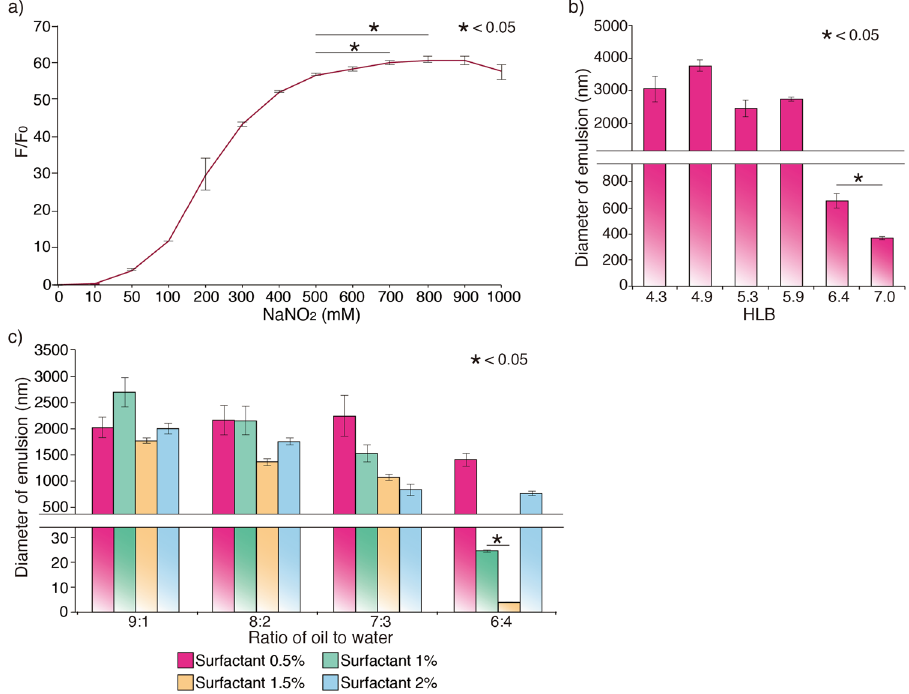
Figure 2. ( a ) Creation of NO in various concentration of NaNO 2 solution. Amount of NO increased until 500 mM NaNO 2 and reached a plateau at 800 mM (F 0 : Fluorescence intensity at 0 mM NaNO 2 solution). ( b ) The size of emulsions prepared with varying HLB value. HLB value of 7 produced the smallest emulsions among the tested HLB values ranging from 4 to 7. ( c ) Diameter of emulsions at different mixture ratio of surfactant, oil and water. The NE was fabricated by mixtures of oil and water in the ratio 6: 4 with 1.5% (v/v)